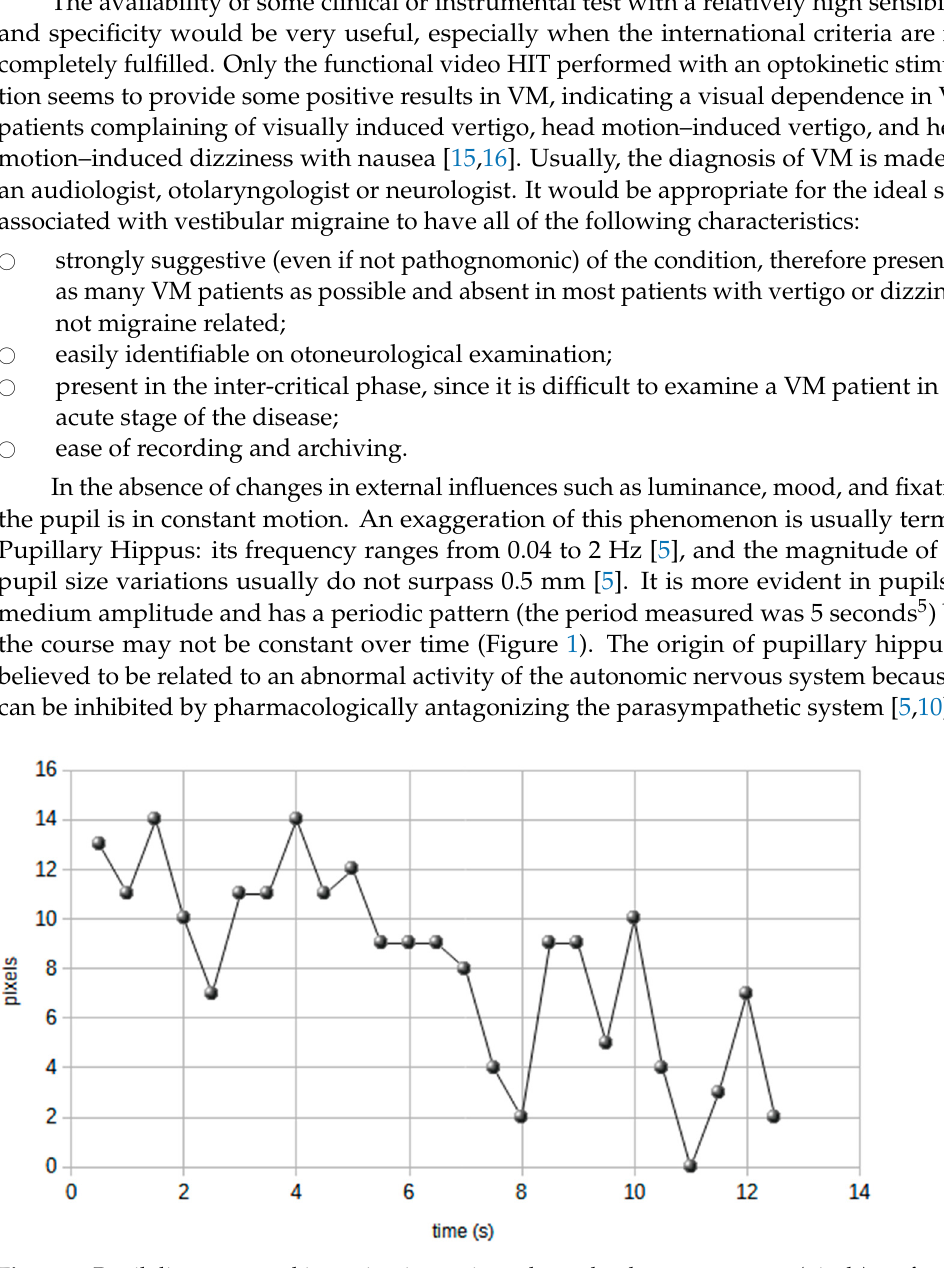
Figure 1. Pupil diameter trend in a migraine patient, shown by the measurement (pixels) performed on the video (by individual